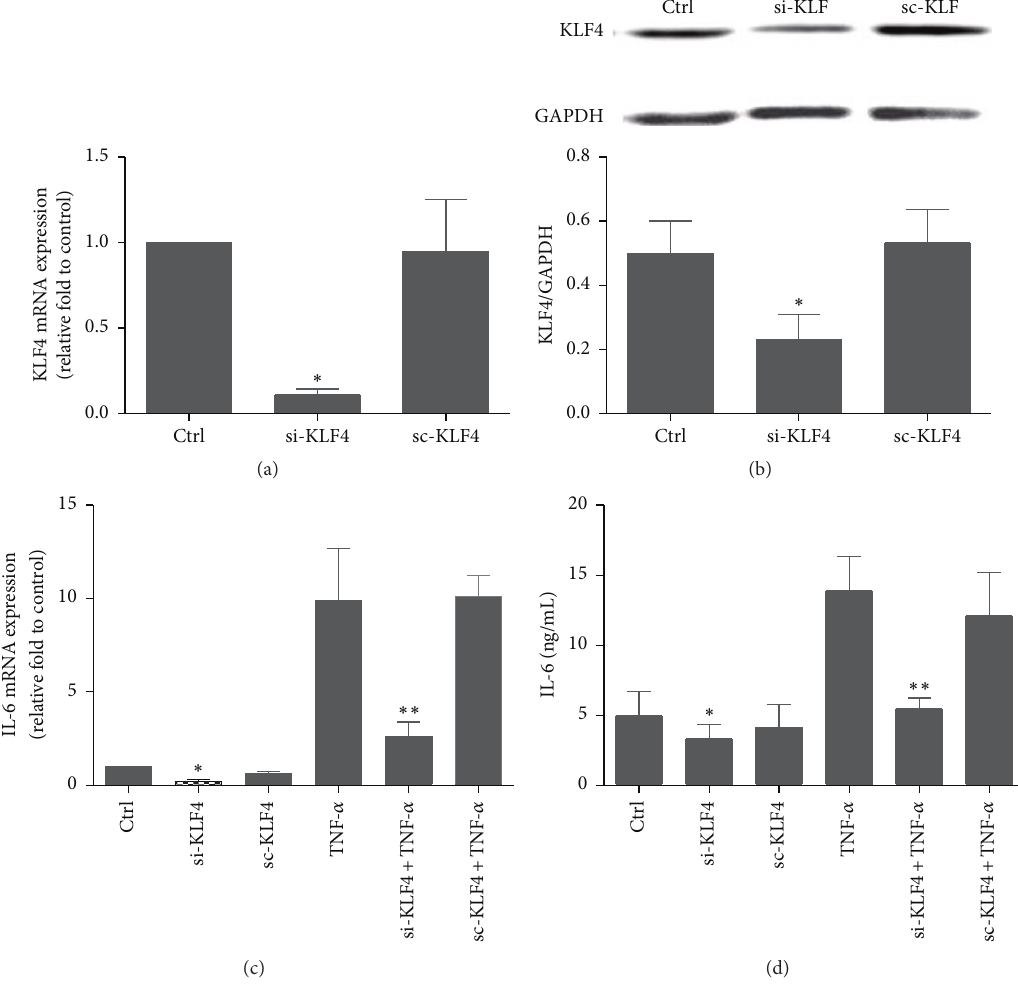
Figure 4: Effect of KLF4 knockdown on IL-6 expression in RA FLSs. RA FLSs were transiently transfected with KLF4 siRNA oligonucleotide (si-KLF4) or KLF4 scrambled siRNA (sc-KLF4) for 48h and then incubated with TNF- 𝛼 (20ng/mL). KLF4 inhibition was assessed after 3 h by real-time PCR (a) and after 12h by western blot (b). IL-6 expression was assessed by real-time PCR (c) and ELISA (d). GAPDH as an endogenous control. Data were expressed as means ± SEM ( 𝑛 = 3 ); ∗ 𝑃 < 0.05 in comparison to the untreated cells (Ctrl); ∗∗ 𝑃 < 0.05 in comparison to the TNF- 𝛼